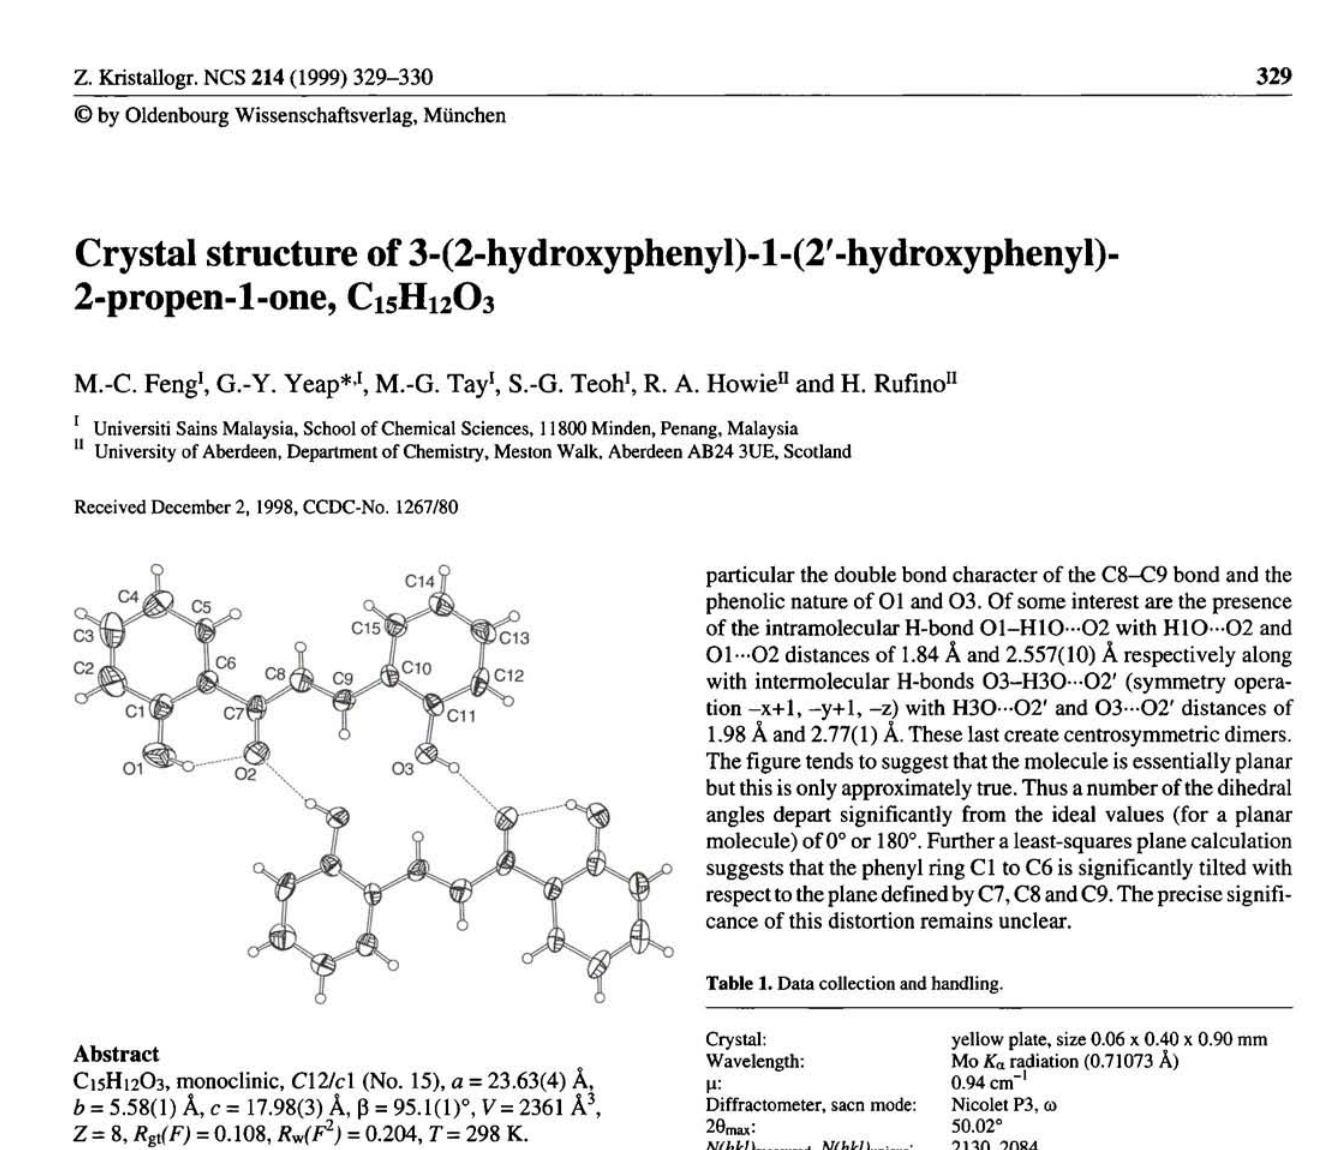
Table 2. Atomic coordinates and displacement parameters (in Â 2